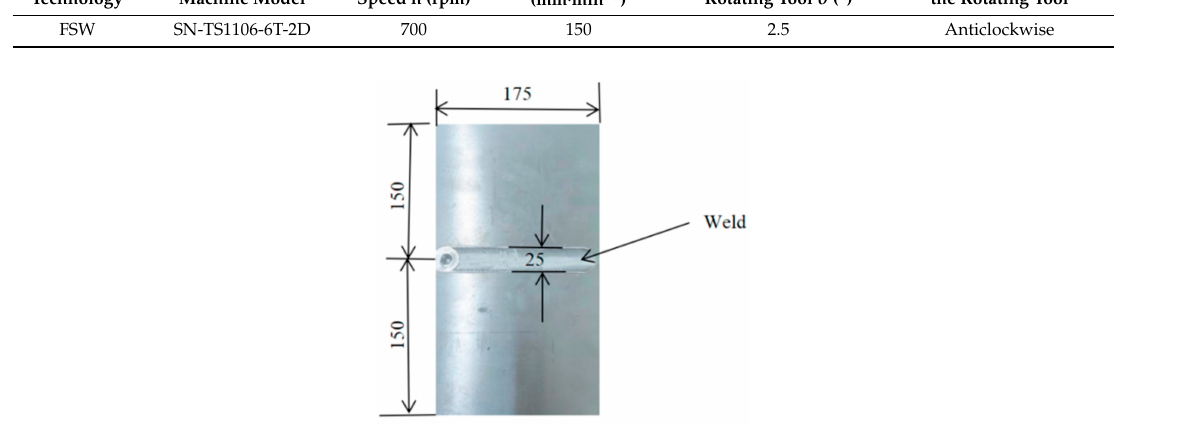
Figure 1. FSW plate (unit: mm).